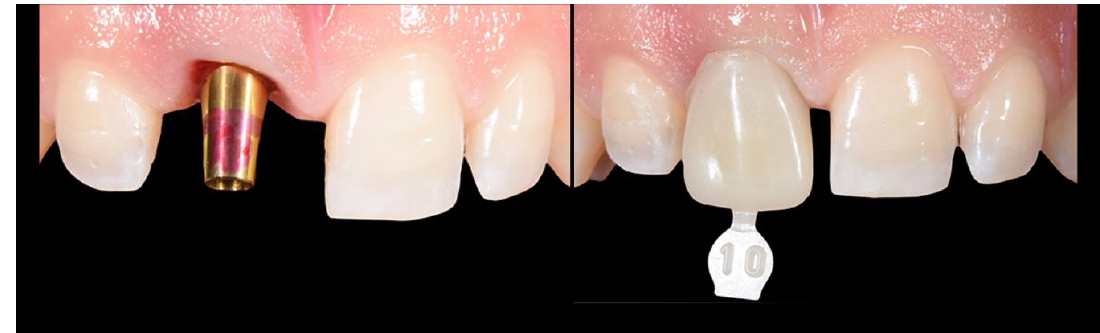
Figure 14. Installation of new abutment and try in of transitional prosthesis.